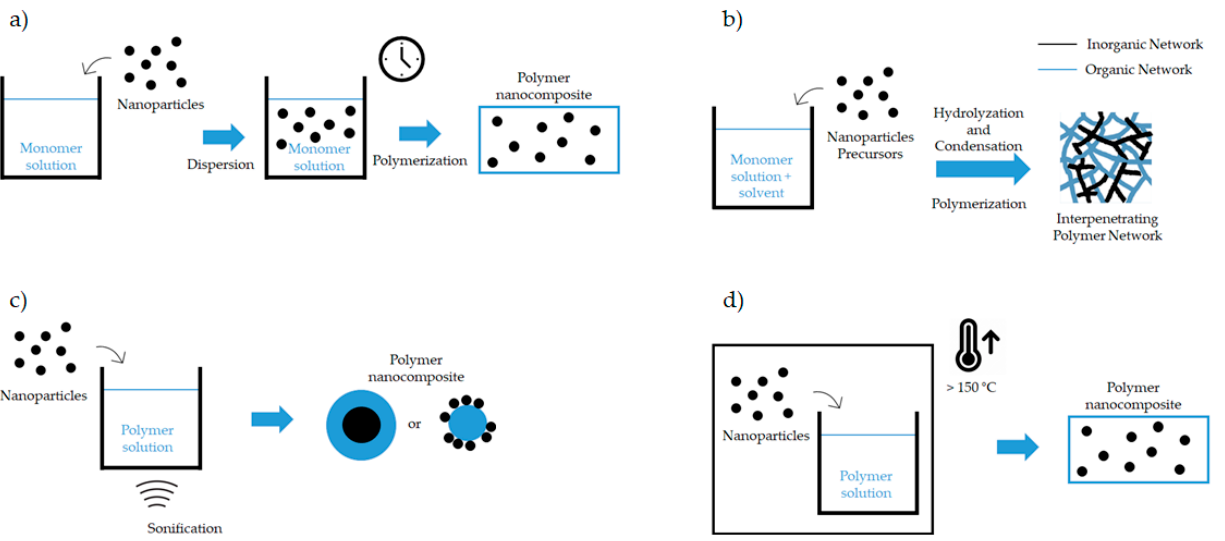
Figure 2. Schematic representation of the immobilization process on the matrix by ( a ) in situ polymerization, ( b ) sol–gel process, ( c ) mixing the catalyst and the polymer, ( d ) hydrothermal pro- cess.